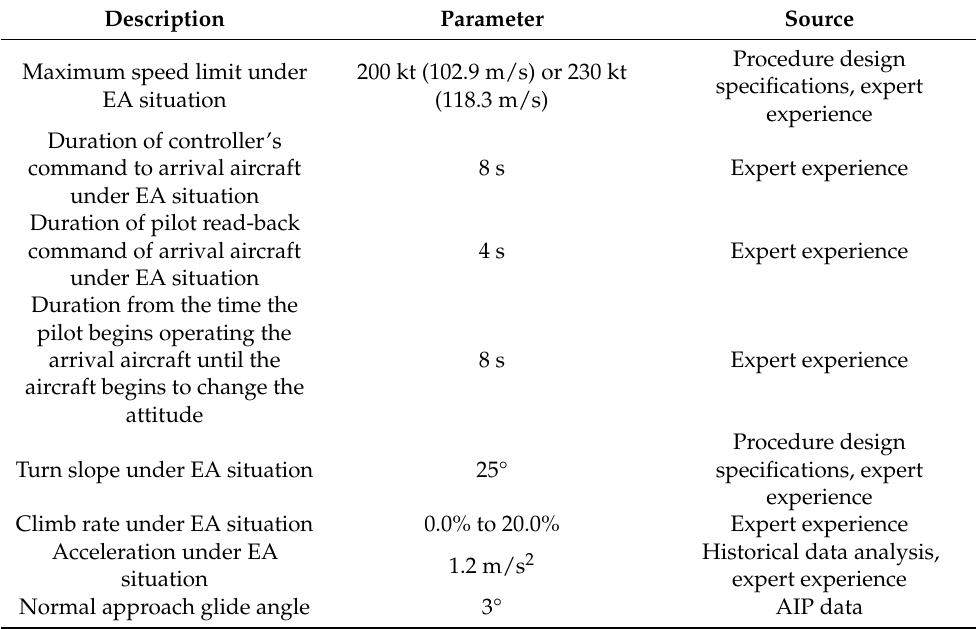
Table 2. Critical parameters of arrival aircraft (A320) to runway